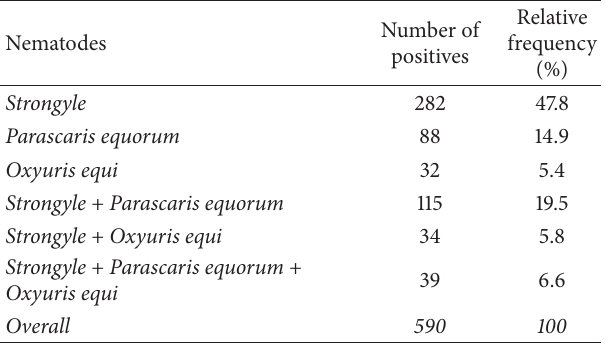
Table 3: The relative proportion of gastrointestinal nematode parasites of donkeys ( Equus asinus ) in northeastern